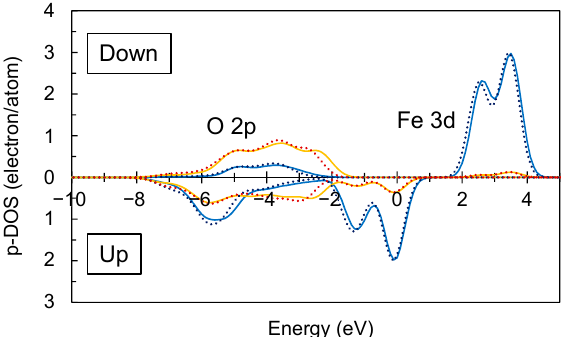
Figure 4. Partial density of states of Fe 3d and O 2p orbitals in γ -LiAlO 2 :Fe 3+ with the HOMO level set at 0 eV. The profiles were drawn with the Gaussian width of 0.3 eV. Solid line: p-DOSs for the relaxed lattice after MD, dotted line: p-DOSs for the unrelaxed lattice without MD.